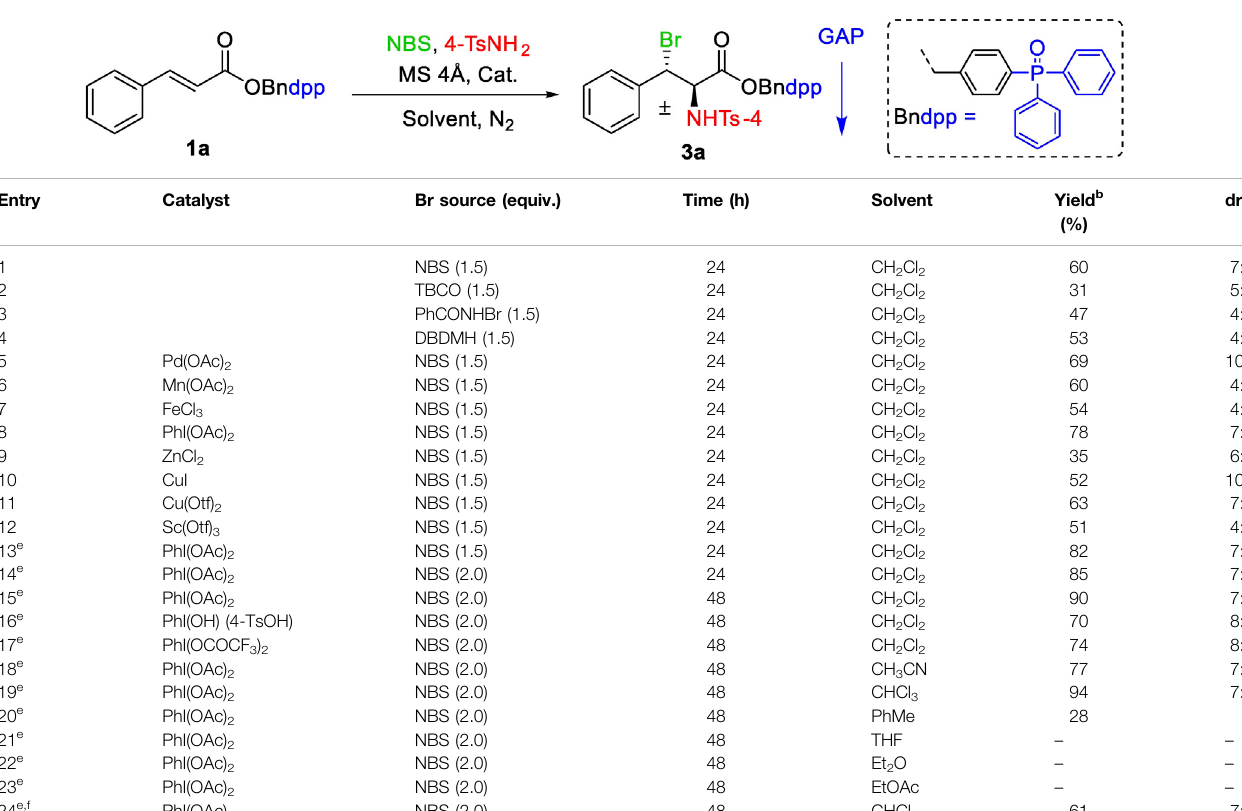
TABLE 1 | Optimization of the reaction conditions.